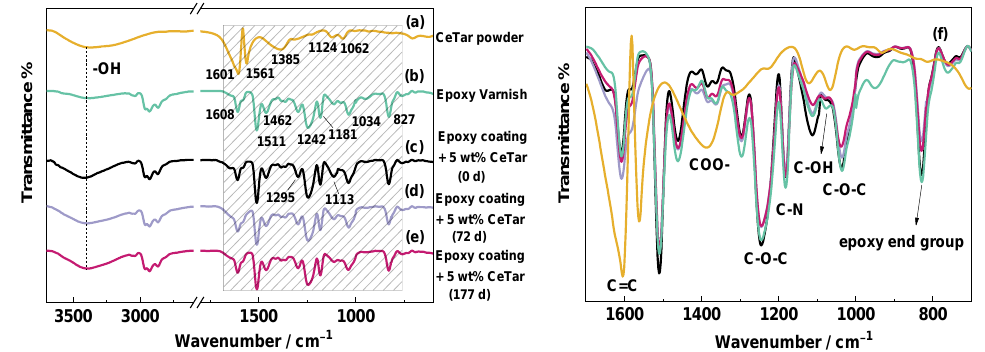
Figure 12. Infrared spectra of ( a ) pure CeTar powder, ( b ) pure epoxy coating, ( c – e ) epoxy coating with 5 wt% CeTar before and after immersion for 72 d and 177 d, ( f ) enlarged graph of the wavelength range 1700 cm −1 – 700 cm −1 .